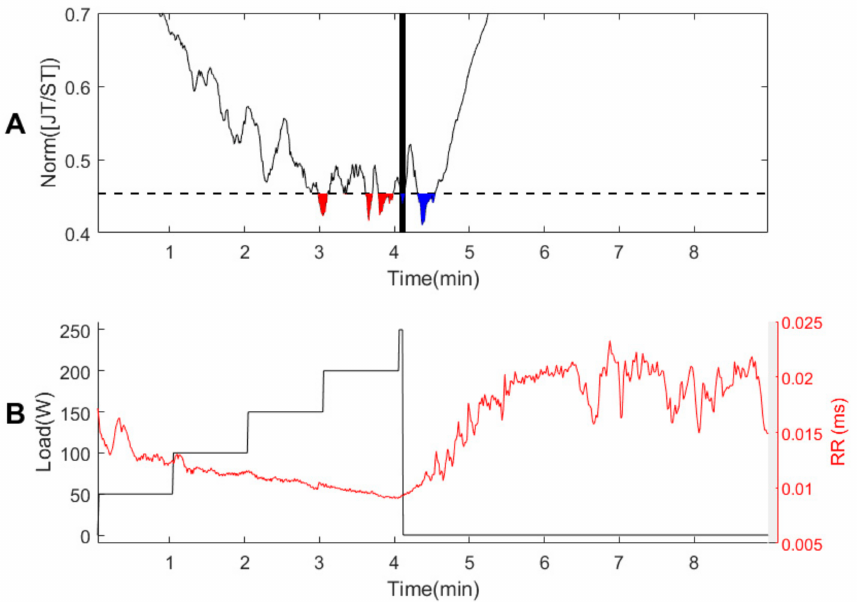
Figure 11. The dynamics of the JT/ST relationship during the load and recovery processes for person #10. The x -axis in parts ( A , B ) represents the time (measured in minutes) from the beginning of the cycle ergometry exercise. The left y-axis in part ( B ) represents the power of the load in Watts. The right y-axis in part ( B ) represents the variation of the RR interval in ms. The algebraic JT/ST relationship is represented by the thin dashed black line in part A. The thick black solid vertical line in part A marks the end of the